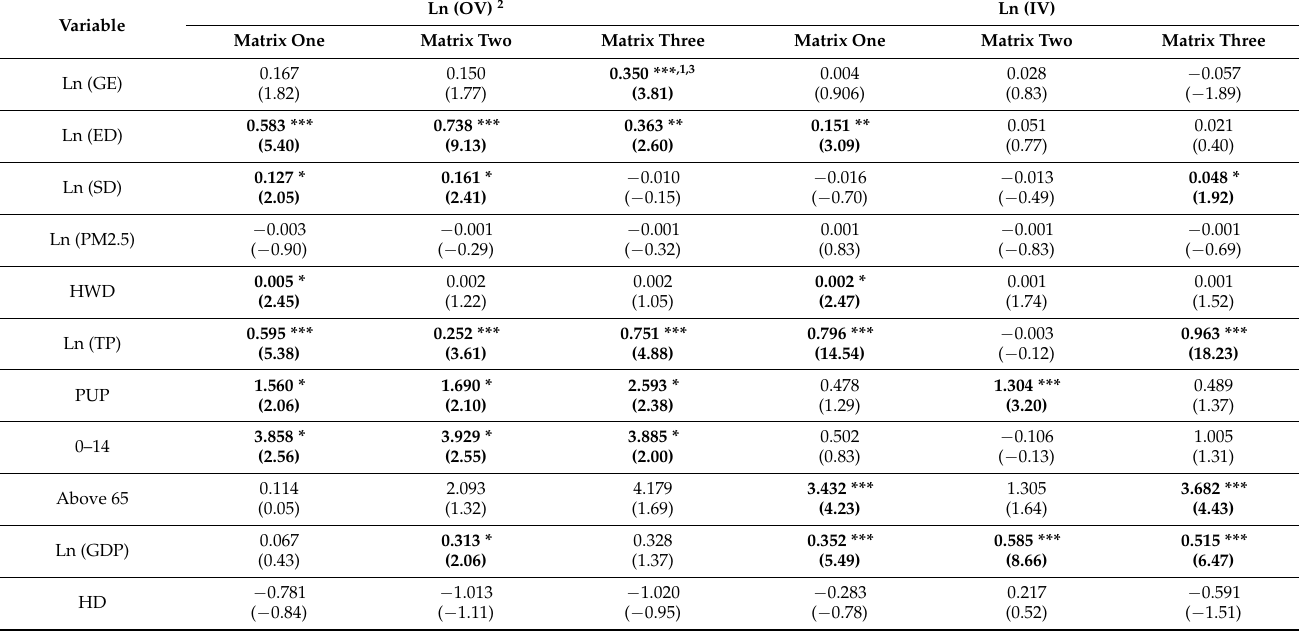
Table 6. Direct effects of the independent variables on healthcare.